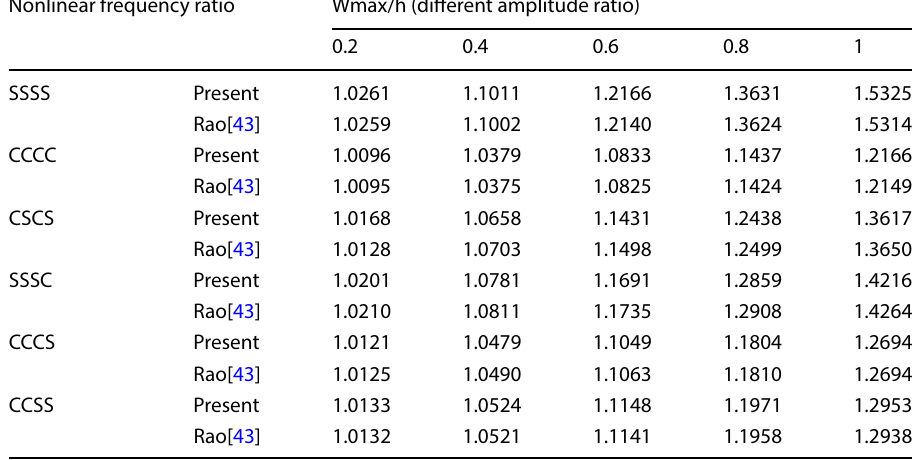
Table 3 Nonlinear natural frequency ratio of square plate compared with Ref [43] for different boundary